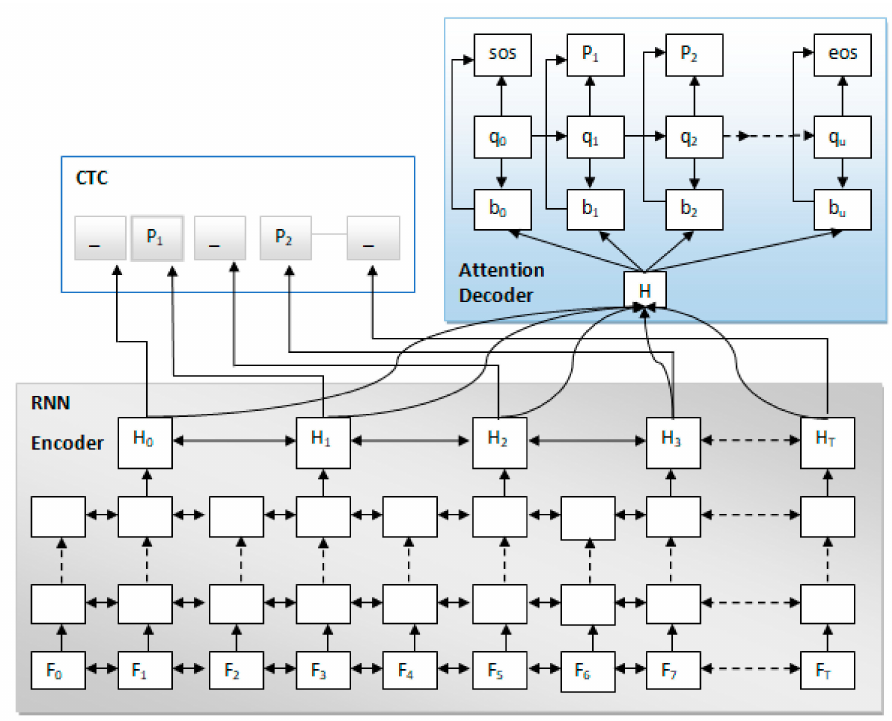
Figure 3. Connectionist temporal classification (CTC)‑attention based end‑to‑end